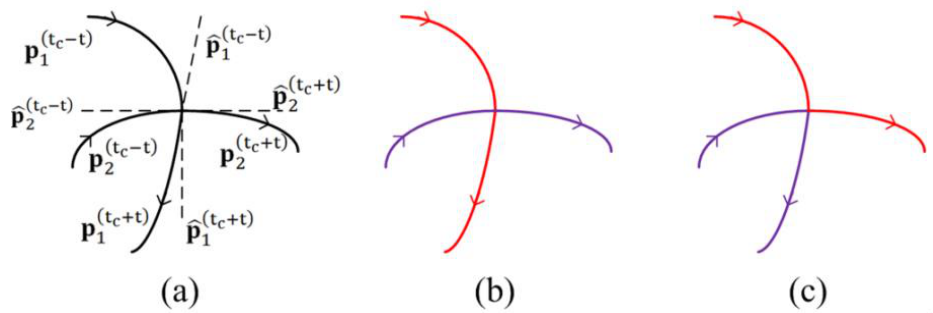
Figure 4. ( a ) The two trajectories obtained from the coordinate correlation intersect at time t c ; ( b , c ) two possible target trajectories; each color represents a target identification.